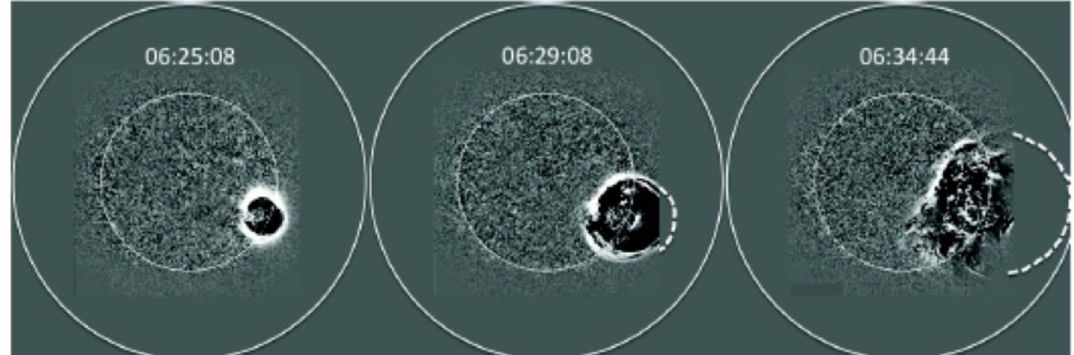
Fig. 4. Three AIA 193 Å base-difference images showing the evolution of an off-limb wave. The data were binned to 4.8 00 /pixel. The outer (solid) circle is 2 R (cid:1) , and the dashed lines indicate the extrapolated portions of the wave outside of the